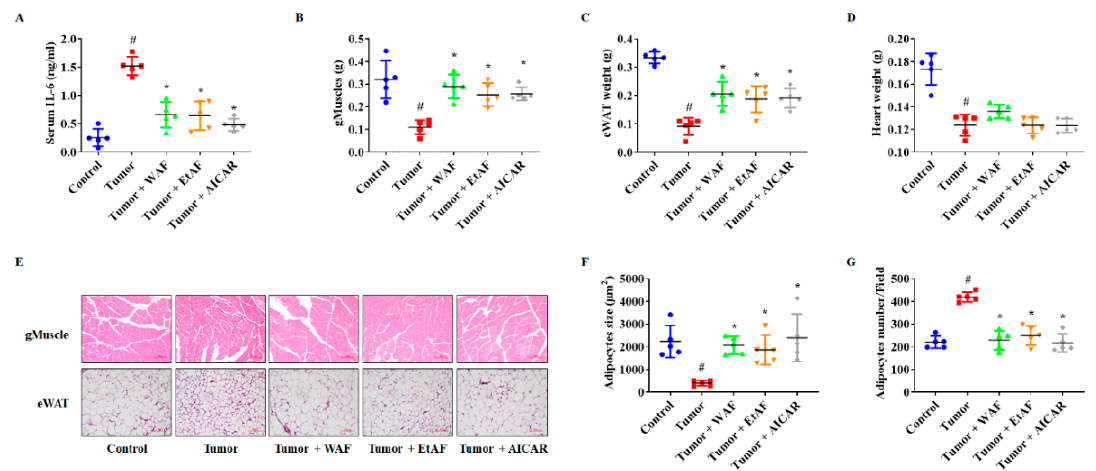
Figure 3. Effects of AF in serum IL-6, muscle weight, and adipose tissue from CT-26 tumor-bearing mice. The serum IL-6 level was determined after sacrificing the mice ( A ). The weights of gMuscle ( B ), eWAT ( C ), and heart ( D ) were measured after sacrificing the mice. The H&E staining images of gMuscle and eWAT. The magnitude is ×200 and the scale bar is 100 μ m ( E ). H&E-stained areas of eWAT were measured using ImageJ ( F ). Adipocytes numbers were counted by randomly selecting fields ( G ). All values are mean ± SD. # p < 0.05, significantly different from control group; * p < 0.05, significantly different from tumor group.